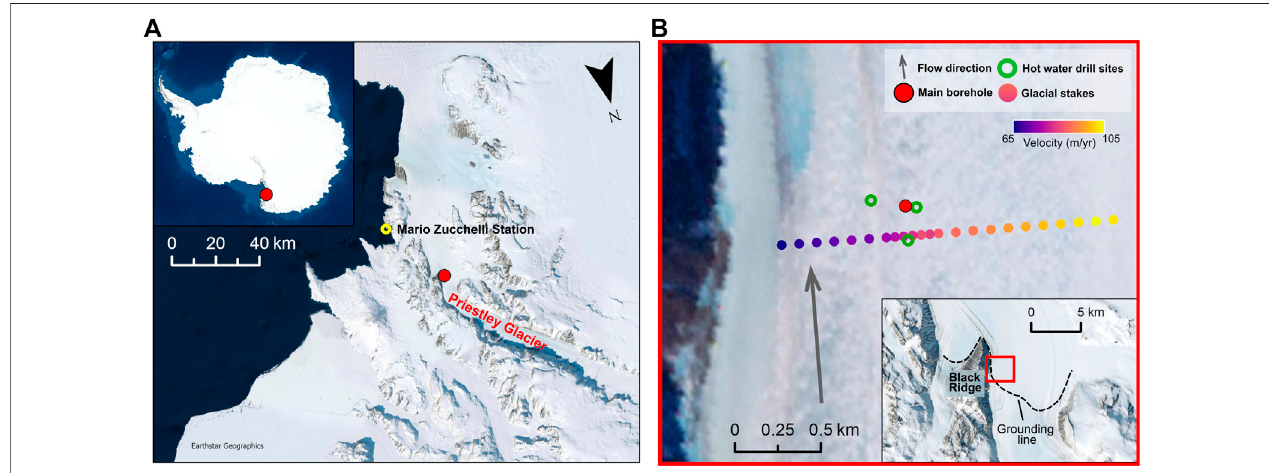
FIGURE 1 | Location map of the fi eld site. (A) Priestley Glacier, Terra Nova Bay area. (B) The locations of the main borehole, hot water drill sites signifying the locations of deep ( ∼ 40 m) seismic and temperature installations, and glacial stakes de fi ning the surface velocity fi eld. A linear color scale gives surface velocity across these glacial